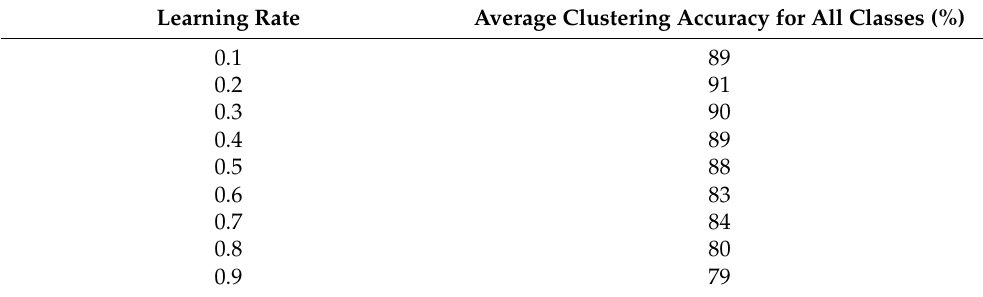
Table 8. Average clustering accuracy for all classes with a hidden layer, 10 neurons, and different learning